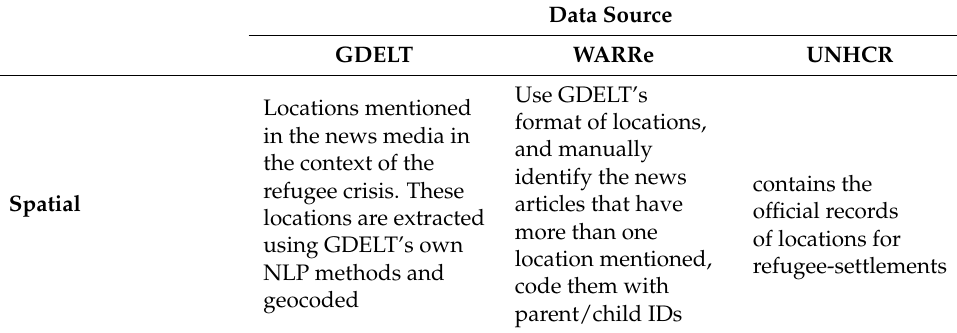
Table 1. A summary of the data-sets